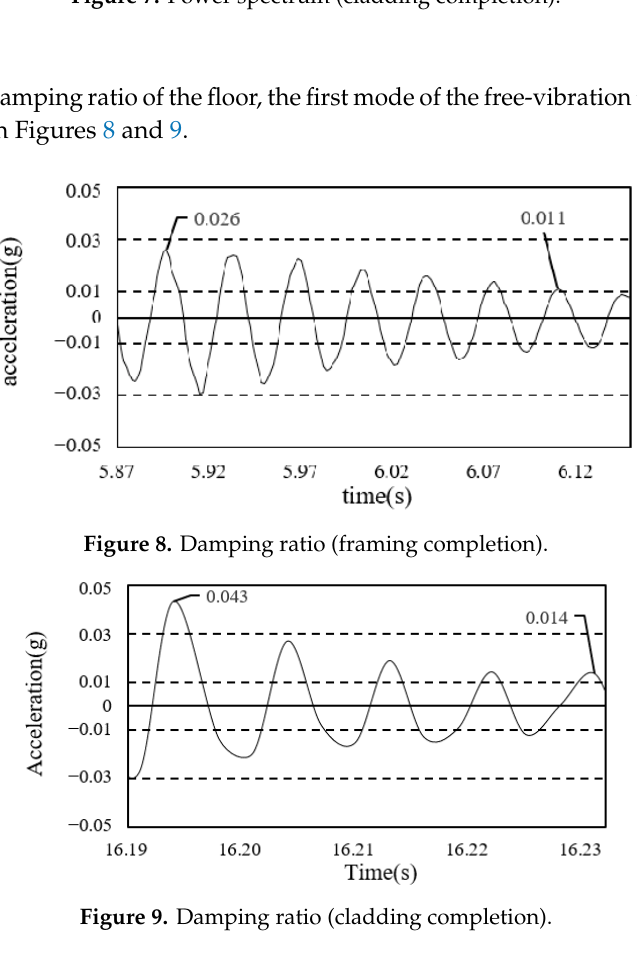
Figure 7. Power spectrum (cladding completion).